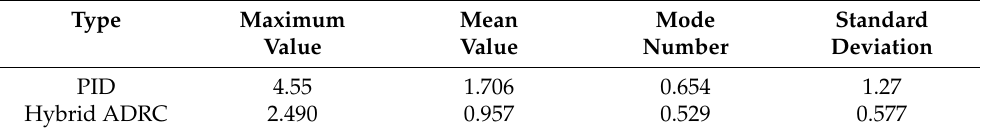
Table 5. Force tracking error analysis of the comparison experiments between PID and Hybrid ADRC with sinusoidal